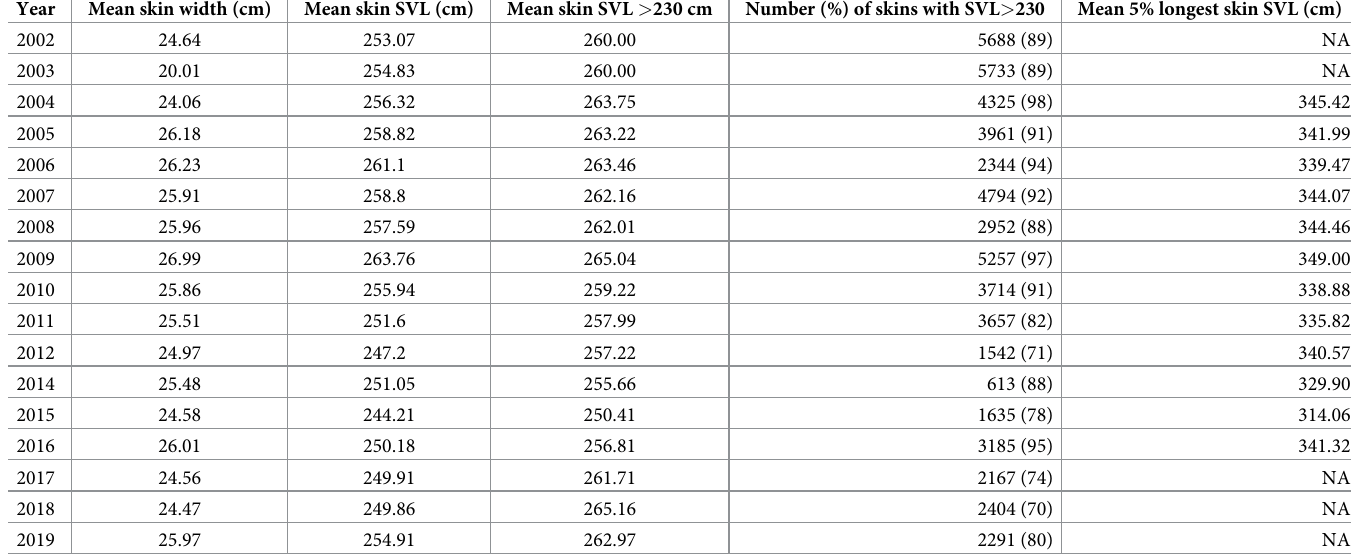
Table 1. Biological attributes of yellow anaconda skins harvested under the Programa Curiyú . Mean skin width, mean snout-vent length (cm), and mean snout-vent length of skins > 230 cm are shown, as well as the number and % of skins with snout-vent length > 230 cm of anacondas harvested between 2002–2019. The mean snout- vent length (cm) of giant skins (corresponding to the 5% longest skins) is shown for the 2004–2016 period. Mean skin width